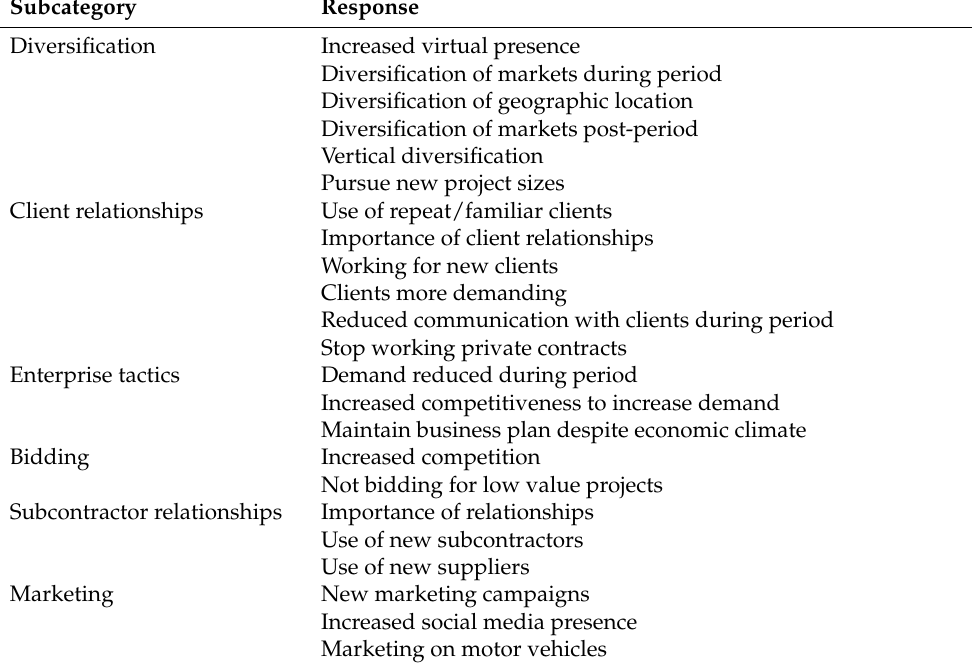
Table 4. Contracting-related